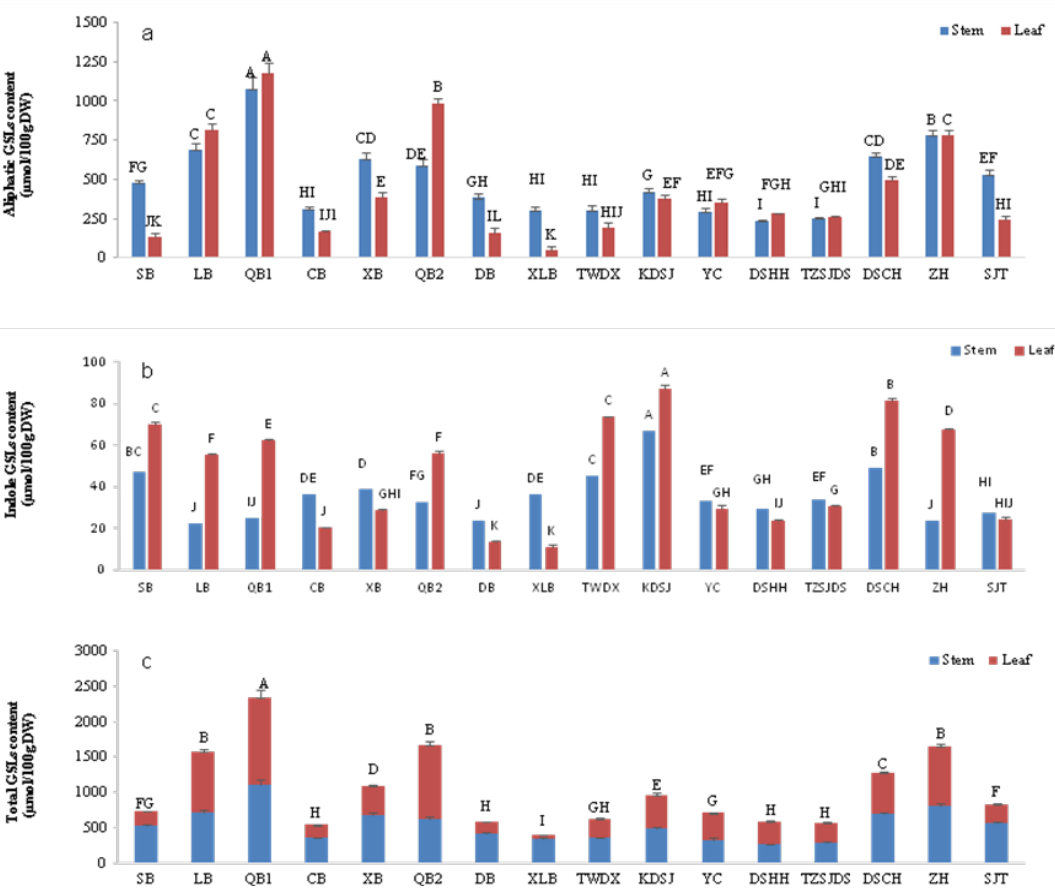
Figure 3. Accumulation of aliphatic, indole and total glucosinolates in stems and leaves of sixteen Chinese kale varieties. Different capital letters indicate extremely significant differences ( p < 0.01). ( a ) Aliphatic glucosinolate content; ( b ) indole glucosinolate content; ( c ) total glucosinolate content.